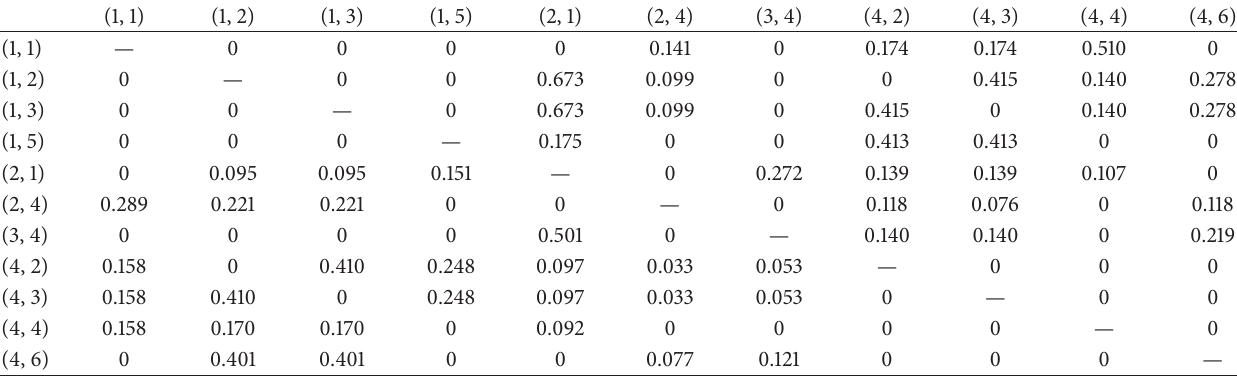
Table 1: An example of calculating the correlations among adjacent edges, where 𝛼 is 0.5. Elements in this figure are normalized results.